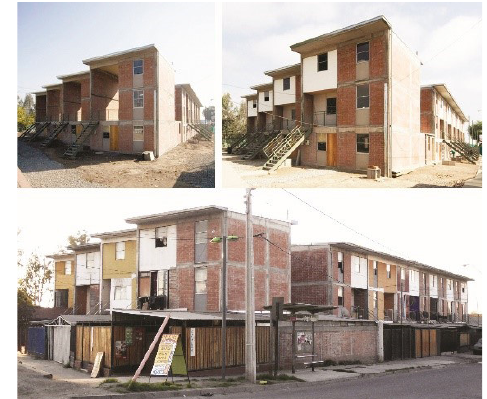
Figure 2. (above) Base house of Lo Espejo, Elemental